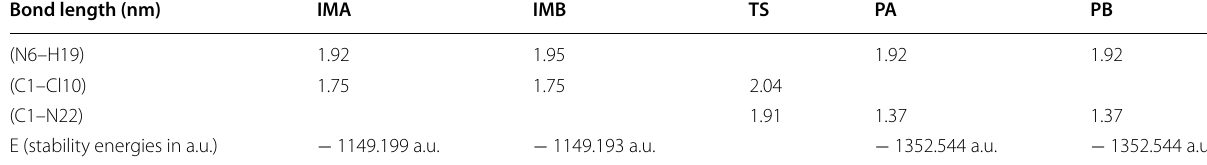
Table 4 The optimized bond lengths (in nm) and stability energies E (a.u.) computed at B3LYP/6-311G (d, p) level of the- ory for IMA, IMB, TS, PA, and PB (see Fig. 4 for atoms